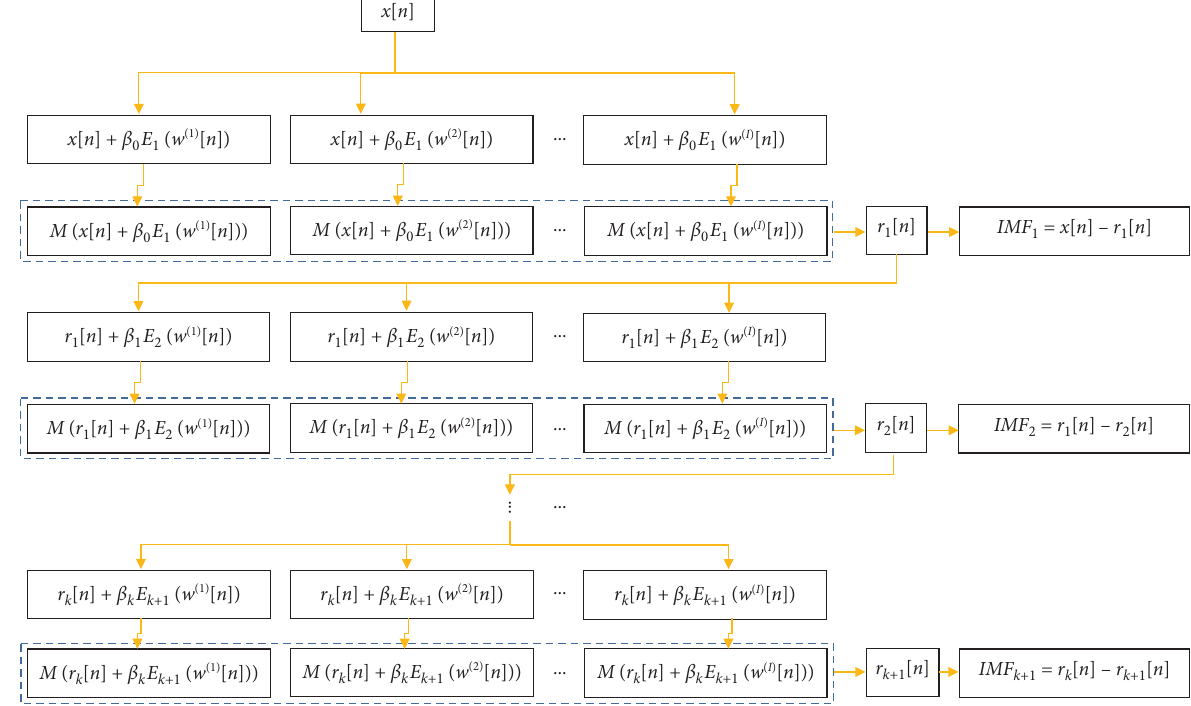
Figure 1: Flowchart of the ICEEMDAN algorithm